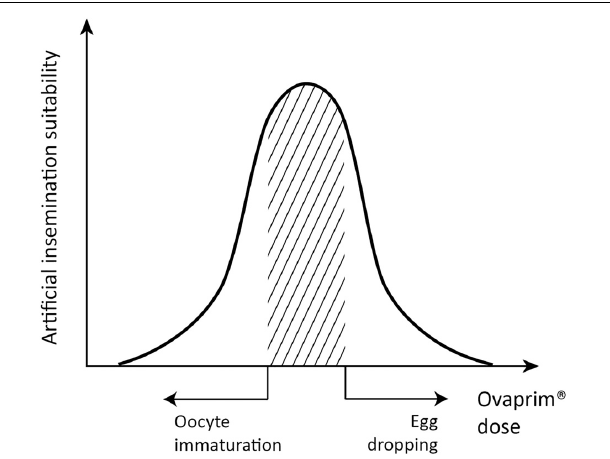
FIGURE 1 | Schematic graph of dose optimization in female sharks. A conceptual graph showing the correlation between biological phenomena ( x -axis) and artificial insemination suitability ( y -axis) that change depending on the total dose of Ovaprim R (cid:13) administered. The shaded area denotes mature oocytes after follicle growth but prior to egg dropping, which is the targeted area for females in this study.